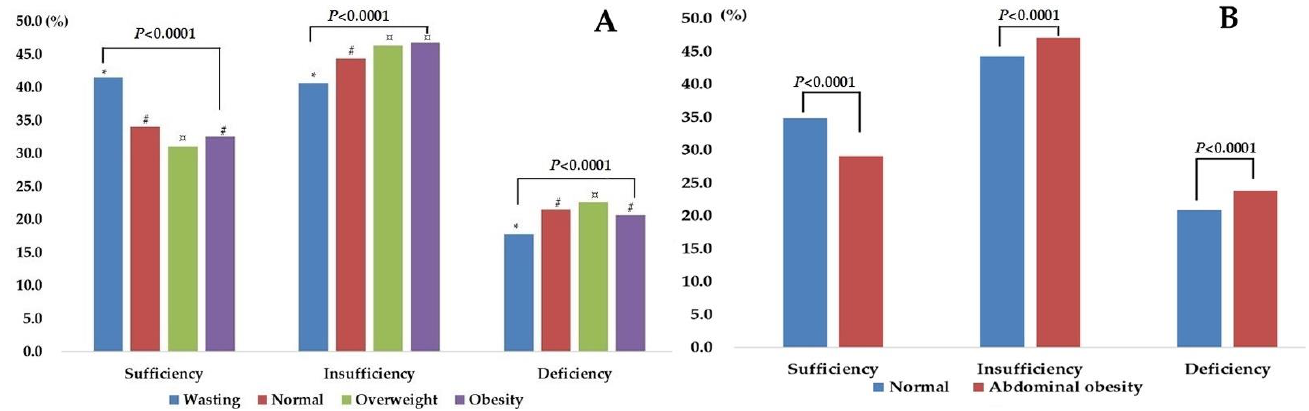
Figure 2. The vitamin D status in different growth level ( A ): *, #, ¤ refers to significant difference between groups; ( B ), normal status versus abdominal obesity.